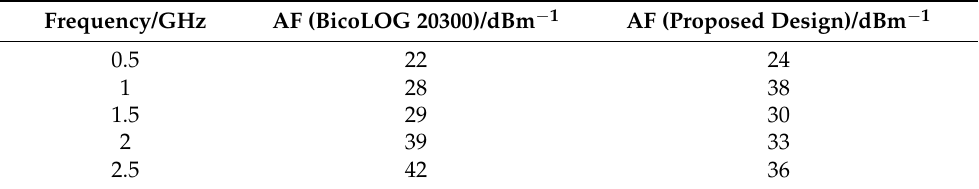
Table 4. Antenna factor comparison of the proposed antenna with the commercial antenna (BicoLOG 20300).